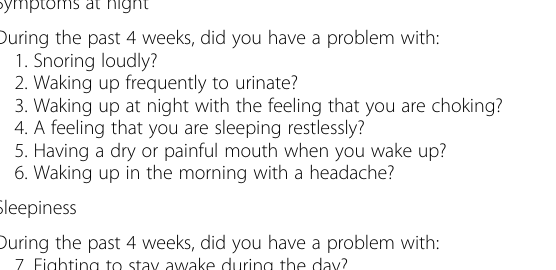
Table 3 English translation of preliminary PRAQ a Symptoms at night